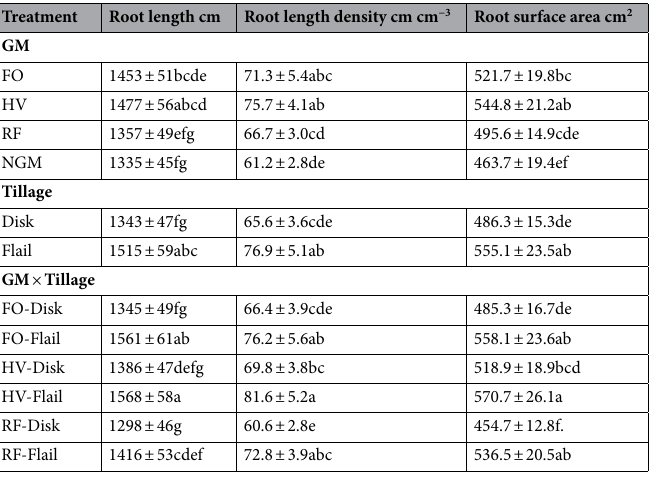
Table 4. Root length, root length density and root surface area of walnut tree as affected by green manure and termination method. The values are means ± standard deviations (n = 3). Values followed by different letters differ significantly (LSD test, P < 0.05). The P values of ANOVA are shown in Table S6. GM green manure; FO February orchid; HV hairy vetch; RF rattail fescue; NGM No green